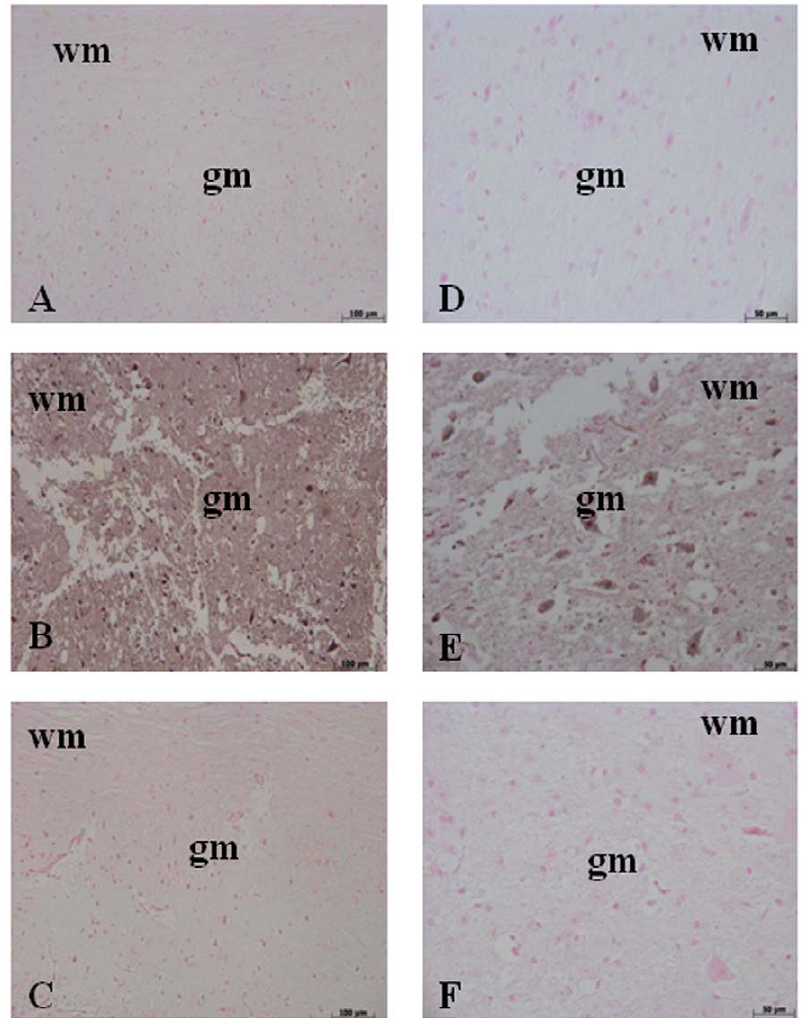
Figure 5. Effects of olprinone on nitrotyrosine formation and PAR. Sections obtained from SCI animals demonstrate positive staining for nitrotyrosine ( B ) mainly localized in inflammatory, in Schwann cells in the white and gray matter. Olprinone treatment (0,2 mg/kg, 1 and 6 h after SCI induction) reduced the degree of positive staining for nitrotyrosine ( C ) in the spinal cord. PAR expression, as an indicator of in vivo PARP activation, revealed the occurrence of positive staining localized in nuclei of Schwann cells in the white and gray matter of the spinal cord tissues from mice subjected to SCI (E). Olprinone treatment reduced the degree of positive staining for PAR (F) in the spinal cord. Figures are representative of at least 3 experiments performed on different experimental